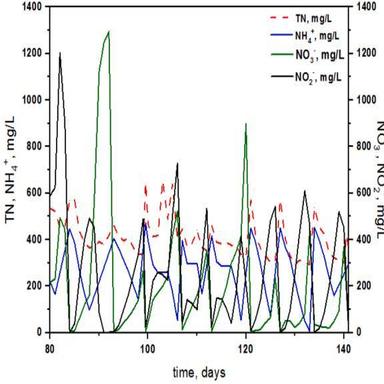
TN, N-NH4 +, N-NO3 - and N-NO2 - evolution during the pre-treated landfill leachate treatment in FBR operated in discontinuous mode and for the maximum treatment capacity found (batch 9).